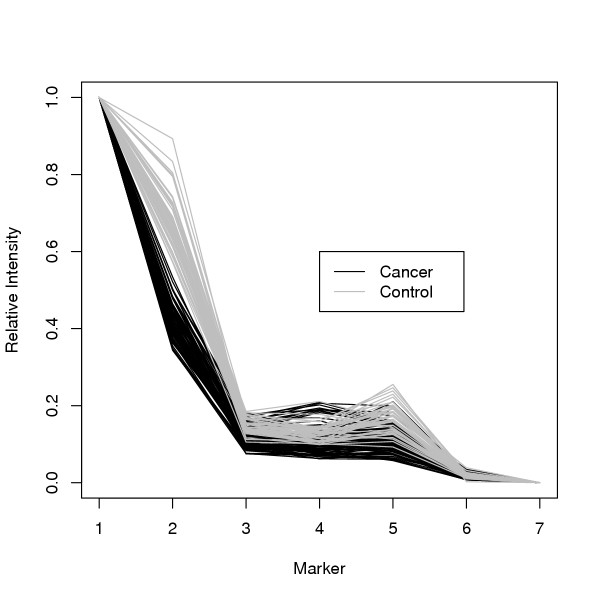
Test set classification of DS1 via 7 markers